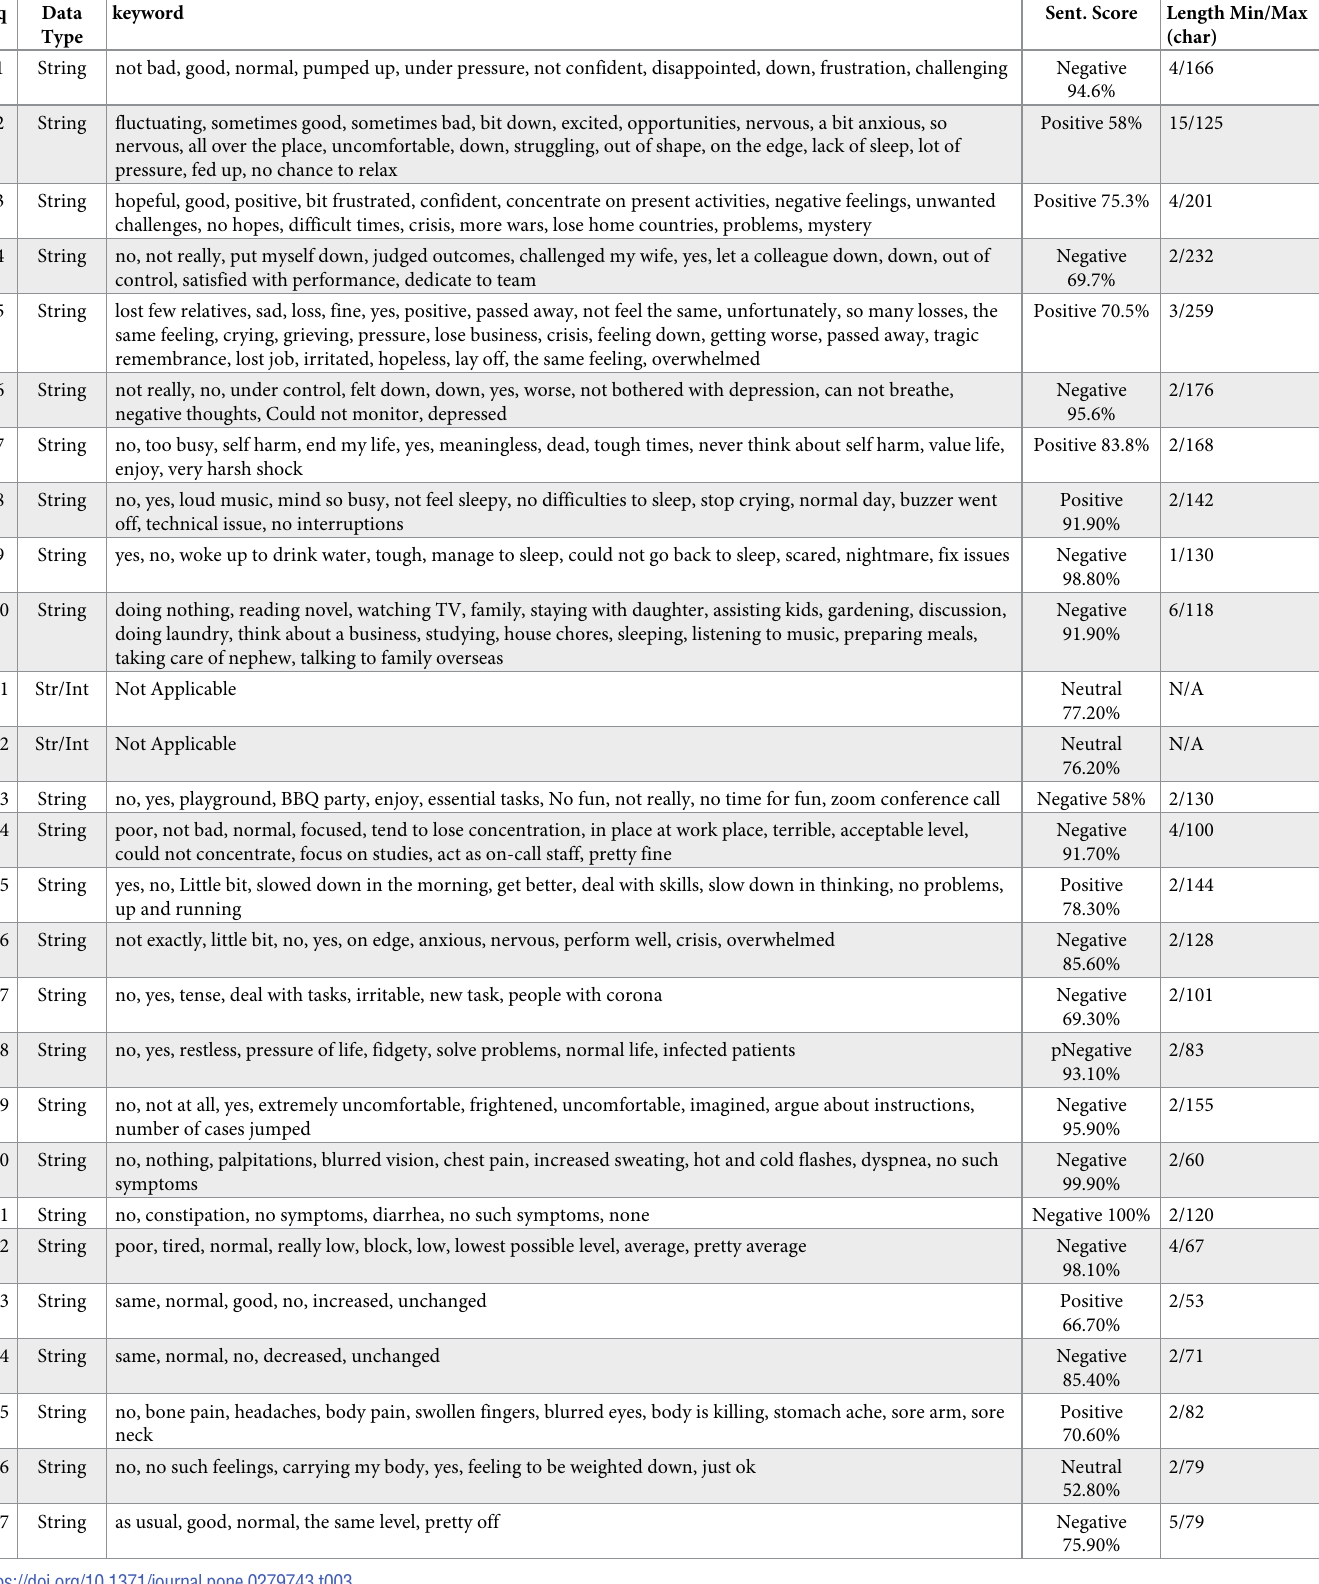
Table 3. Sequence of